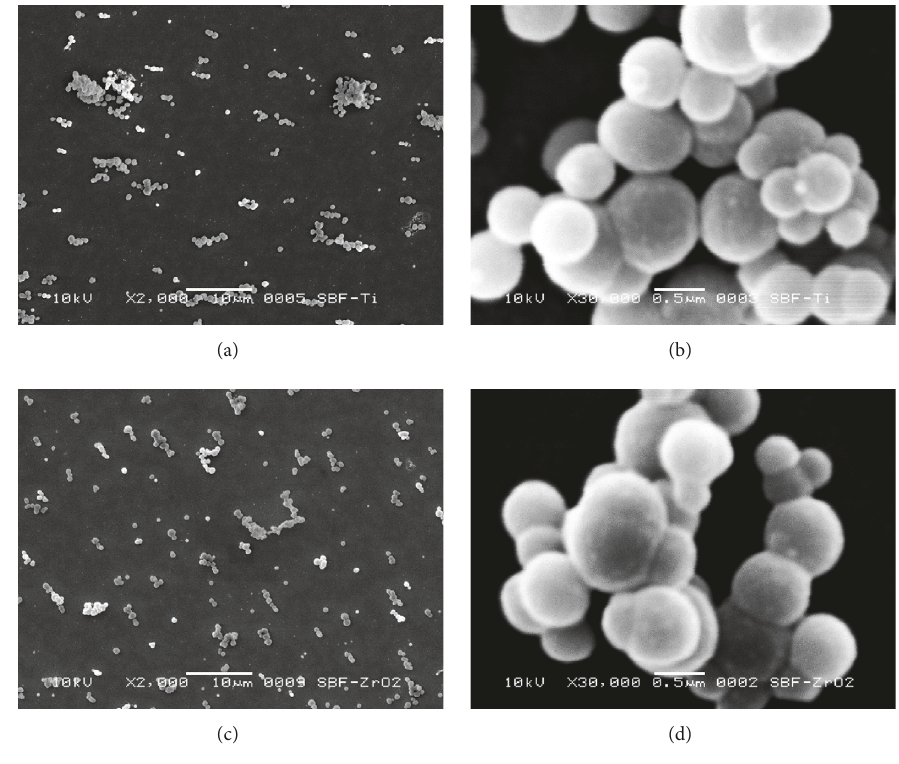
Figure 5: SEM pictures of apatite crystals on each sensor after 24 hours of SBF immersion. (a, c) Apatite crystals on Ti sensor with lower and higher magnification. (b, d) Apatite crystals on ZrO 2 sensor with lower and higher